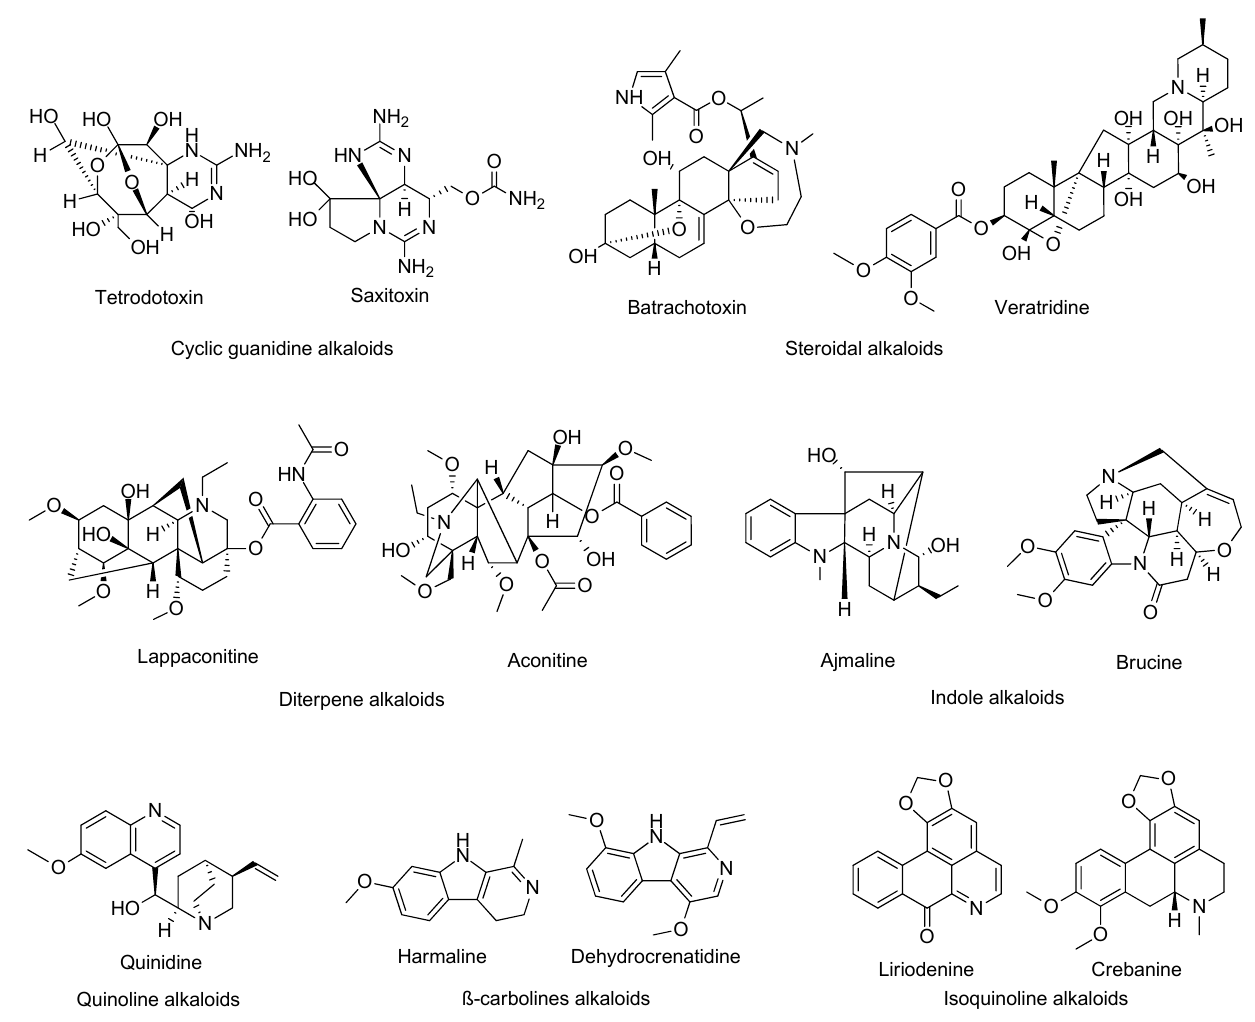
Figure 1. Structural diversity of natural alkaloids active on Na V channels. Tetrodotoxin and saxitoxin are two marine guanidine alkaloids. Veratridine, aconitine, and batrachotoxin are activators of the Na V channels. Lappaconitine, quinidine, and ajmaline are two inhibitors used as clinical drugs. Liriodenine and crebanine, two IA, block the Na V channels. Lappaconitine, which is structurally related to aconitine [15] , exhibits potent analgesic properties [16] and has recently been proposed for the treatment of chronic pain [17]. Ajmaline, isolated from Rauwolfia serpentina, inhibits the Na V 1.5 channels [18–21]. Ajmaline is used in the diagnosis and treatment of cardiac arrhythmia [22]. Brucine, extracted from Nux vomica , exhibits antinociceptive properties mediated by Na V channel inhibition [23]. Harmaline from Peganum harmala [24] and dehydrocrenatidine from Picrasma quassioides are used to treat pain [25].